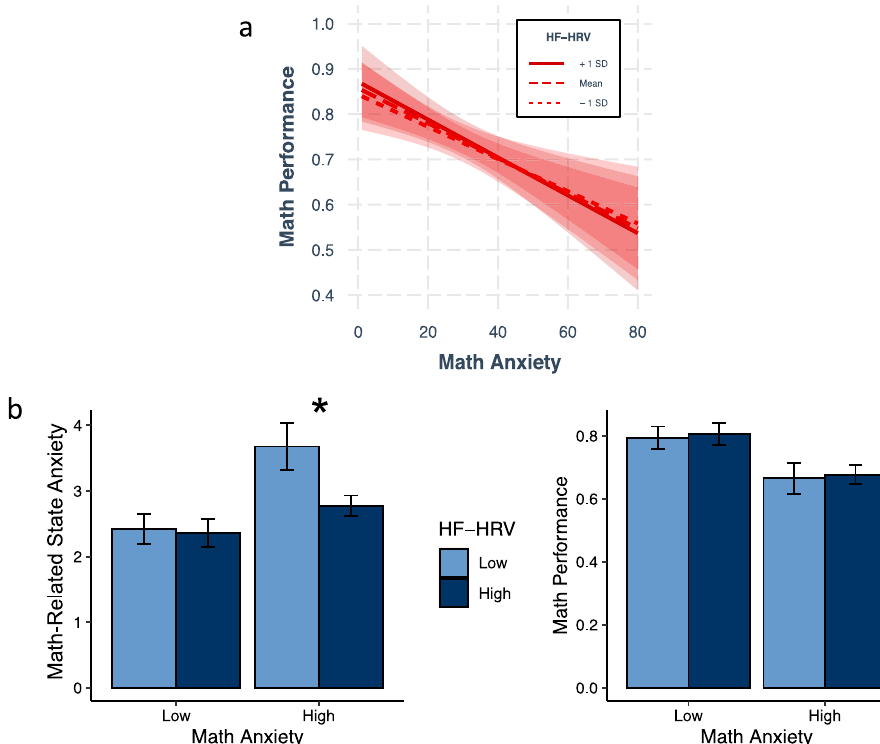
Fig. 4 Unpacking the Moderating Role of HF-HRV. ( a ) shows that the magnitude of the association between math anxiety and math performance is not dependent on HF-HRV. ( b ) shows average levels of math-related state anxiety (left) and math performance (right) broken down by median splits on both math anxiety and HF-HRV. For the purposes of this fi gure, participants were considered “ High ” on math anxiety or HF-HRV if their score on that metric was above the median, and “ Low ” if it was at or below the median. Error bars re fl ect standard errors. * Indicates a signi fi cant difference as a function of HF-HRV at p <